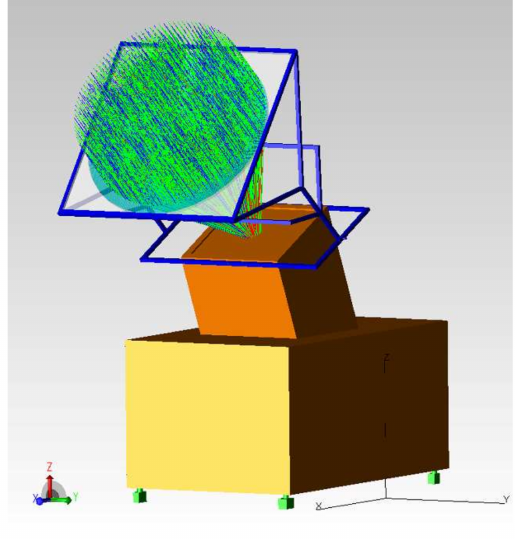
Figure 7. The ray path passing through fixed-focus Fresnel lens solar